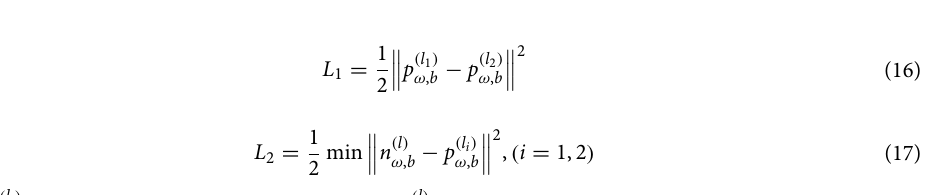
Figure 4. Adjustment chart of feature difference. (It is used to illustrate the triple Loss function proposed in this paper. The software is Microsoft Office